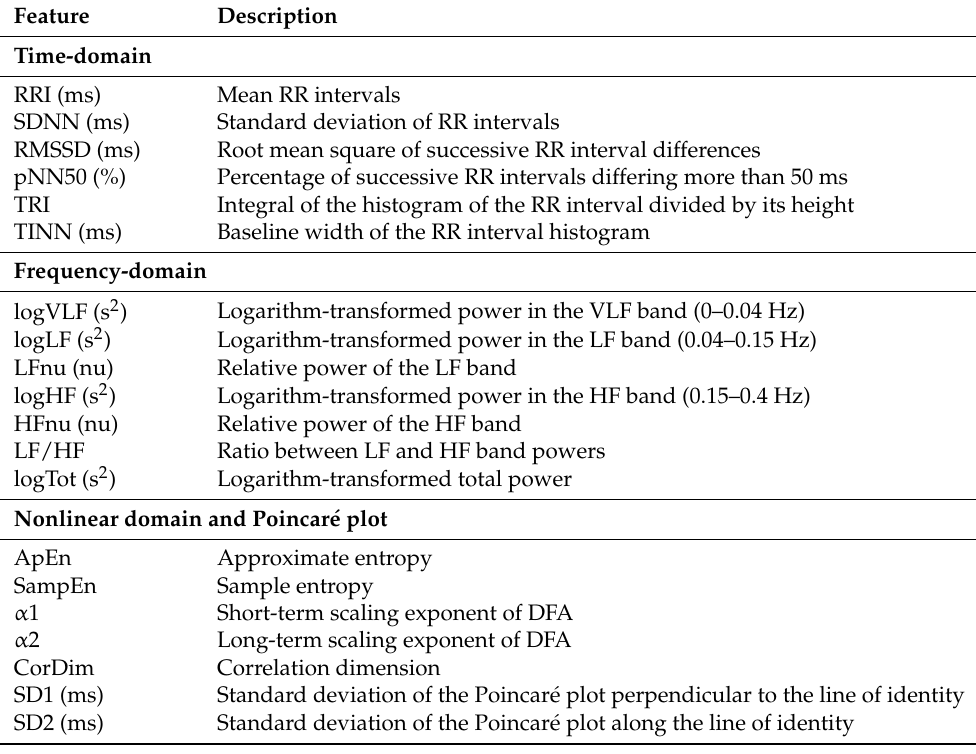
Table 2. Description of HRV